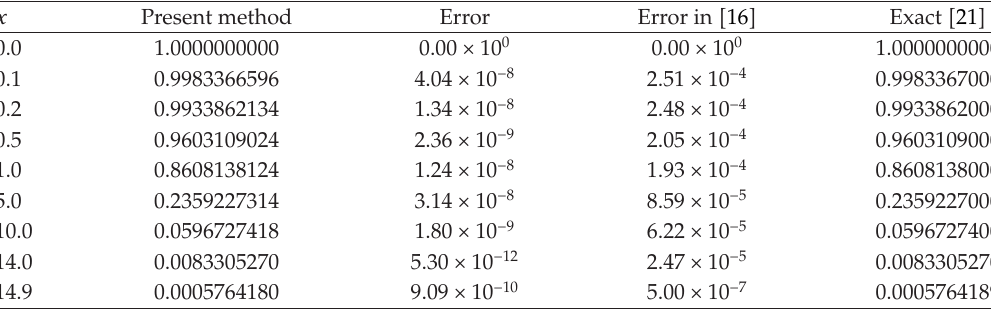
Table 5: Comparison of y (cid:3) x (cid:4) for present method, and other methods in the literature for α (cid:5) 4.